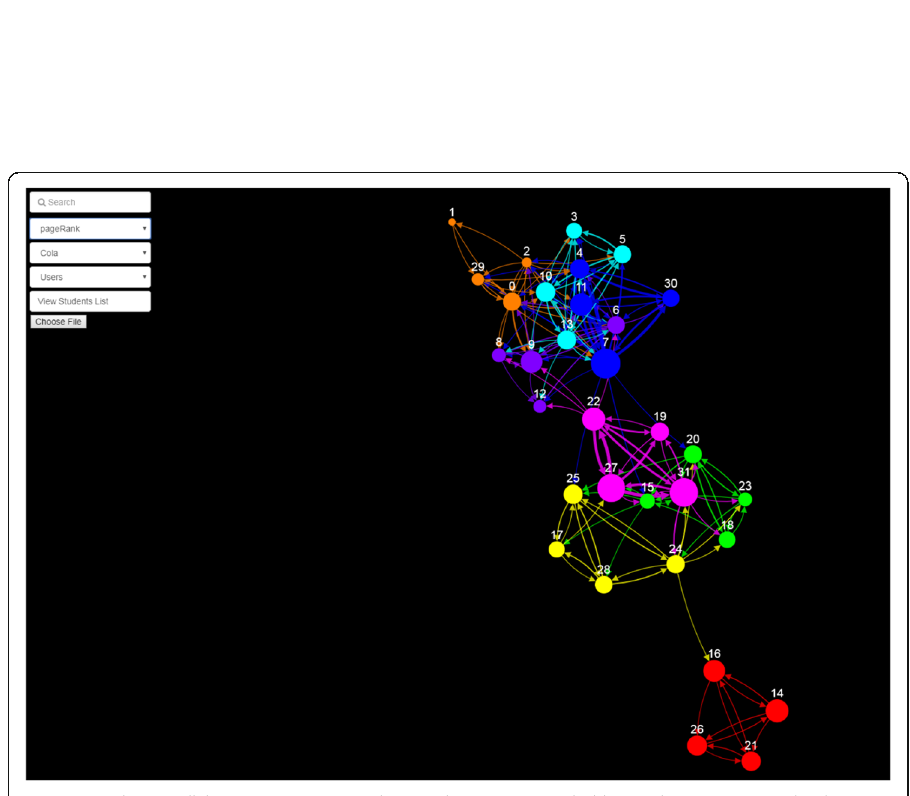
Fig. 11 Students ’ collaboration on Twitter. The visualization is provided by StudentViz using WebCola layout. Nodes represent students and their diameters are proportional to PageRank metric. Through this image, similar with Fig. 10, the instructor can visualize the collaboration status for a specific social media tool (in this case, Twitter). This figure supports VN1 and VN2, as well as P1, P2 and